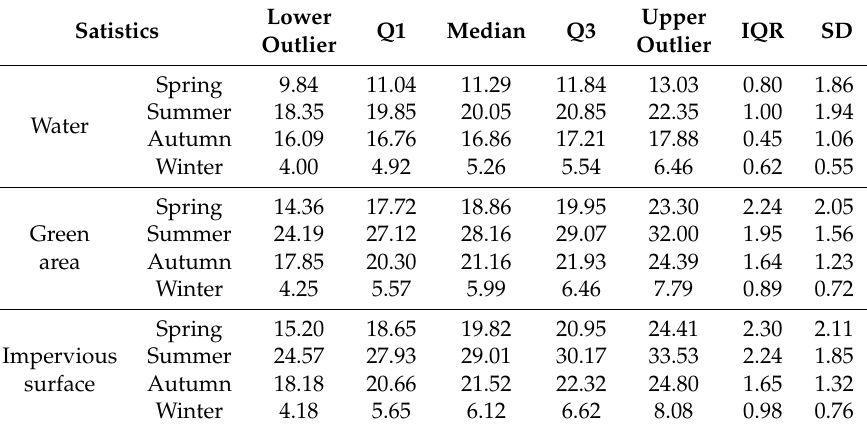
Table A4. Statistics of box plot for